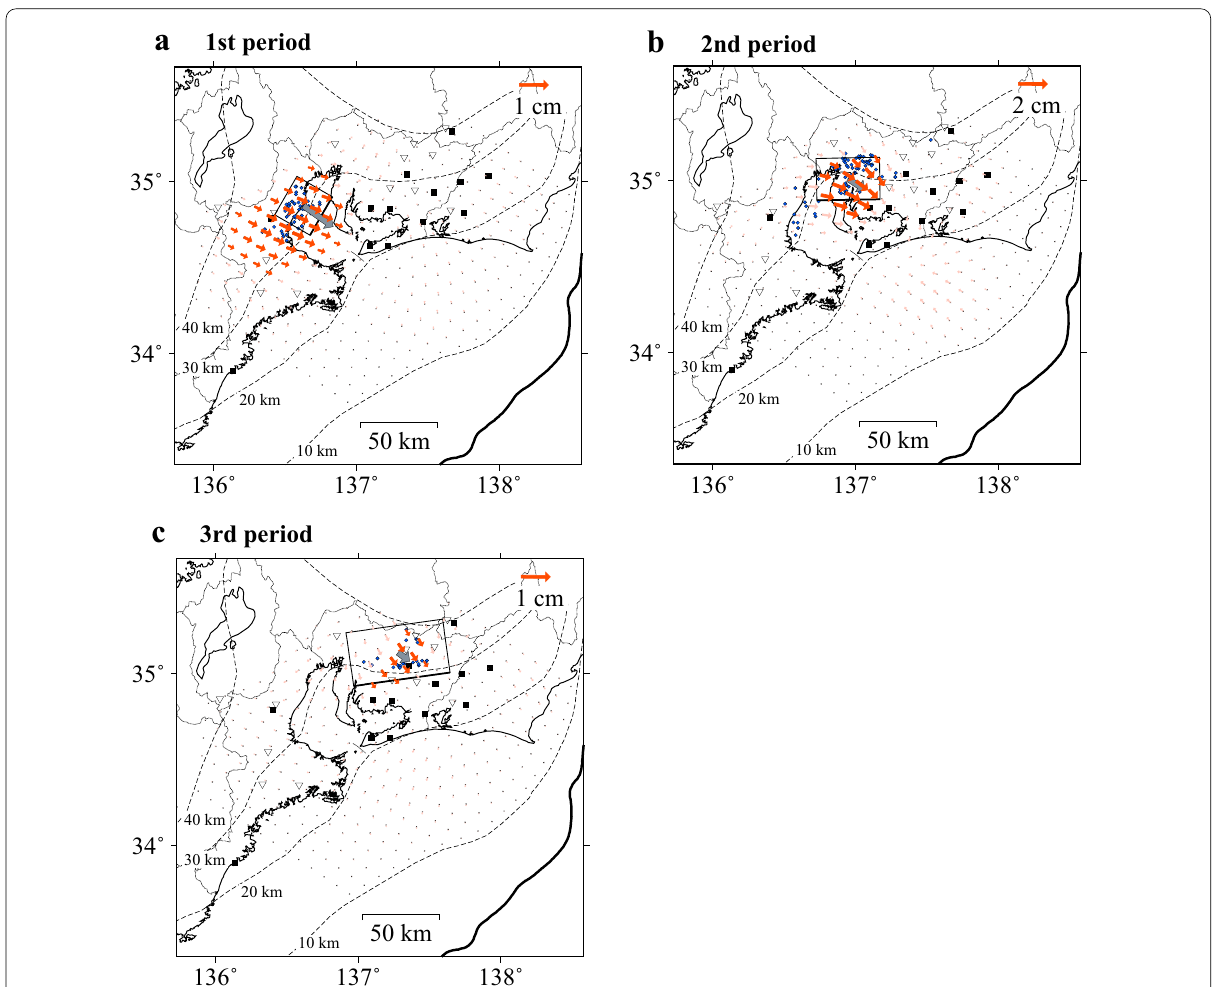
Fig. 12 Estimated slip distributions during 29 December 2015–7 January 2016. Map region corresponds to Area A in Fig. 1. a Surface projection of estimated slip distribution on the plate interface (arrows) and a rectangular fault model (rectangle and gray arrow) for the first period (29 December 2015–1 January 2016). Slips exceeding the standard deviation (1 σ ) are shown in red and slips below the 1 σ are shown in light pink. Colored dots are LFT epicenters in this period (see Fig. 10). The solid line indicates the Nankai Trough and the dashed contours indicate the depth of the Philippine Sea plate. b Surface projection of estimated slip distribution on the plate interface and a rectangular fault model for the second period (1 January to 1200 on 5 January). c Surface projection of estimated slip distribution on the plate interface and a rectangular fault model for the third period